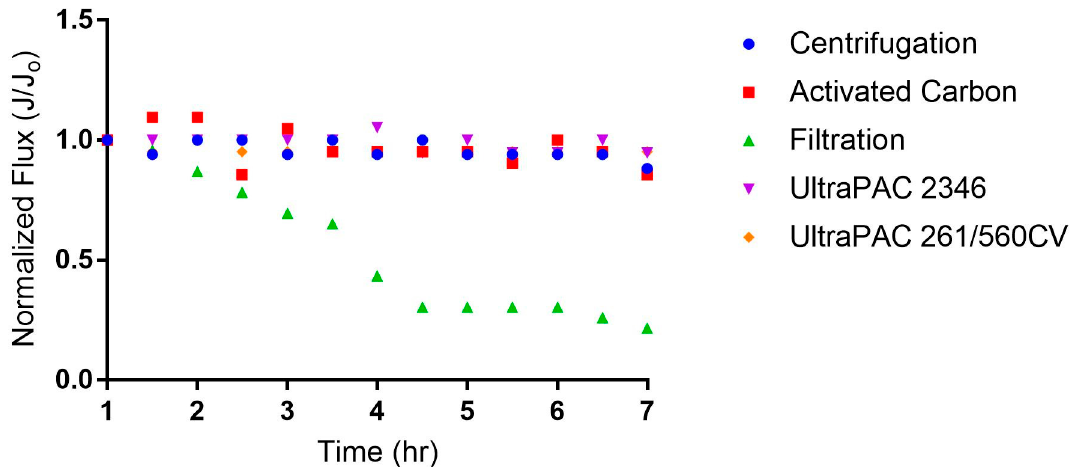
Figure 4. Normalized flux of the five pretreated produced water samples used for a FS for the FO trials.